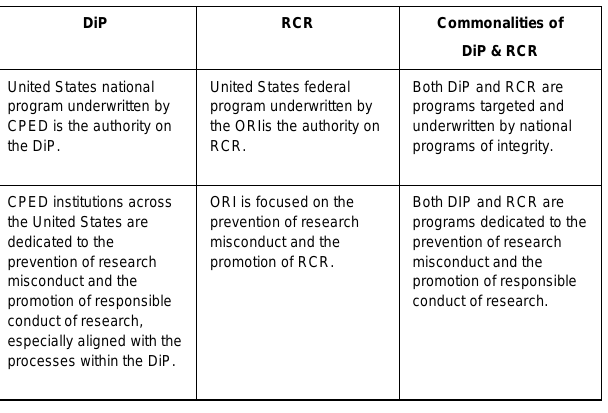
Figure 1. Overview of the Proposed DiP and RCR Conceptual Argument DiP RCR Commonalities of United States national program underwritten by CPED is the authority on the